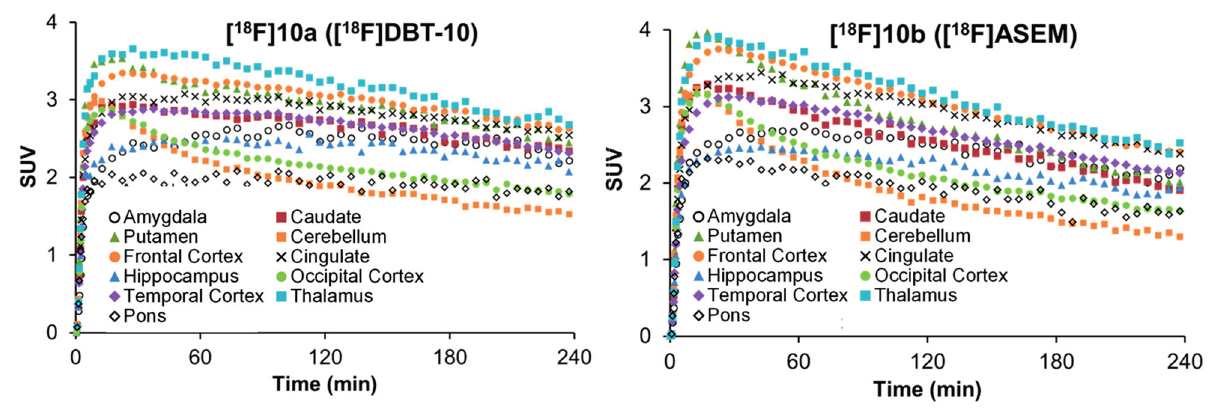
Figure 5. Time-activity curves of [ 18 F]DBT-10 and [ 18 F]ASEM in selected brain regions of a rhesus